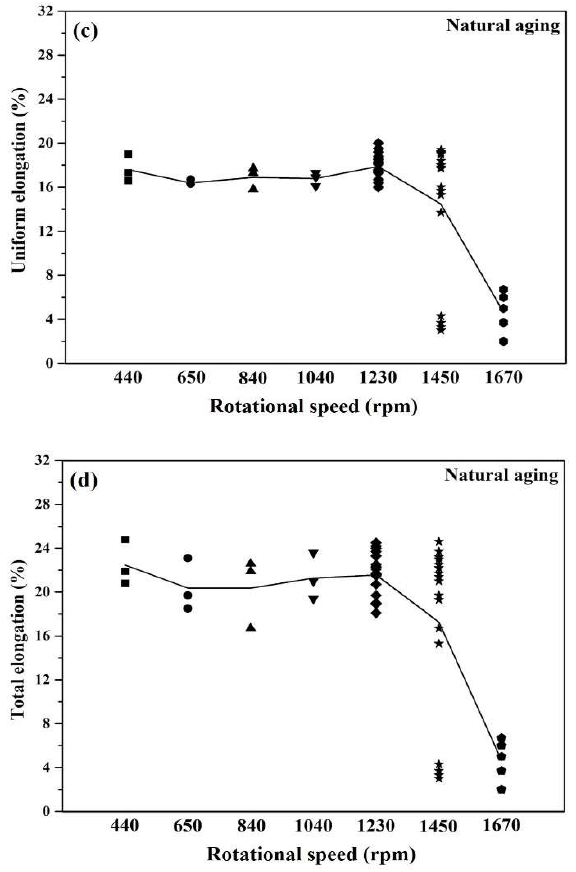
Figure 3. Tensile test of FSP specimens at various rotational speeds after natural aging: ( a ) yield strength (YS); ( b ) ultimate tensile strength (UTS); ( c ) uniform elongation (UE); and ( d ) total elongation (TE).